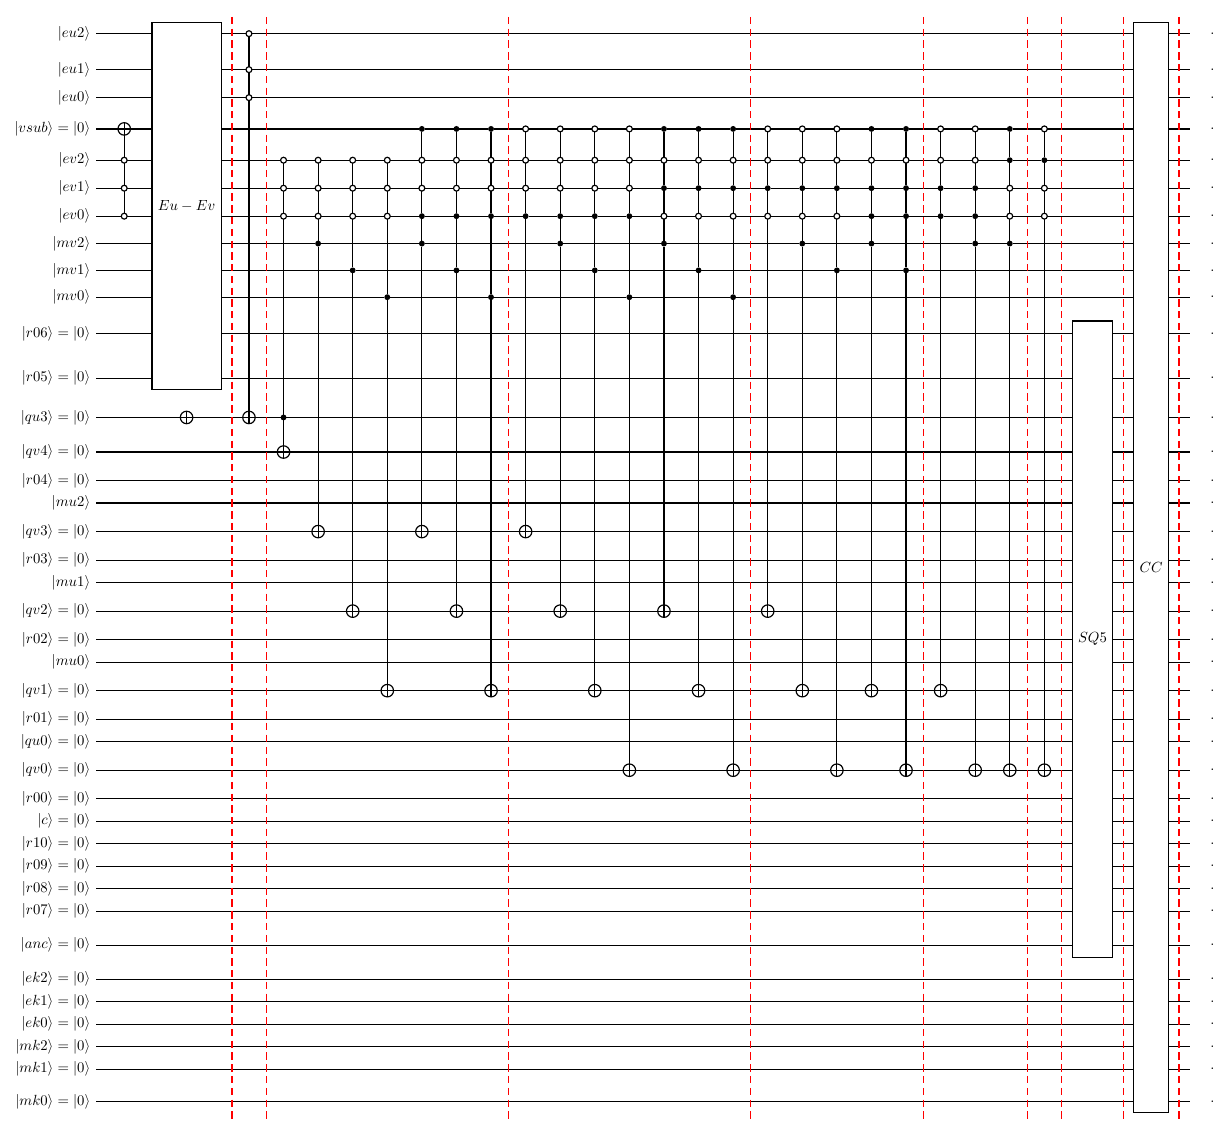
Figure 14. Design EKin2D3 with ( N M + 3 )